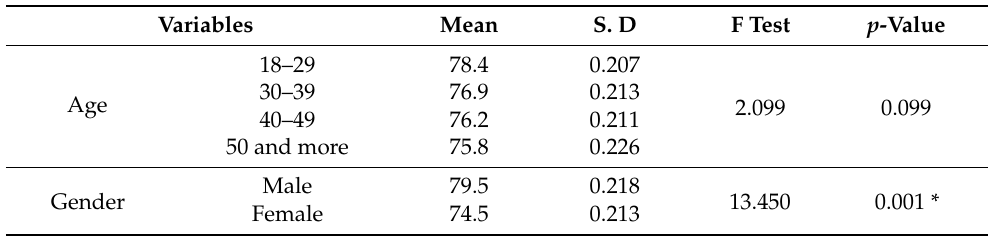
Table 3. Correlation of variables to assess the knowledge regarding COVID-19 and willingness to vaccinate children for